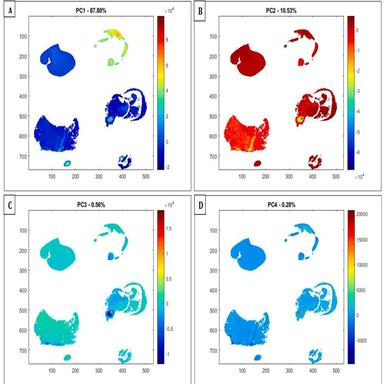
PCA model of the NMI obtained at ambient temperature, displaying the composite image of the first four PCs (PC1, PC2, PC3 and PC4 graphical mapping surfaces, A-D) with the corresponding explained variance. The color gradient from blue to red is used to visually indicate these scores, with blue representing lower scores (or more negative scores) and red representing higher scores (or more positive scores). (For interpretation of the references to color in this figure legend, the reader is referred to the web